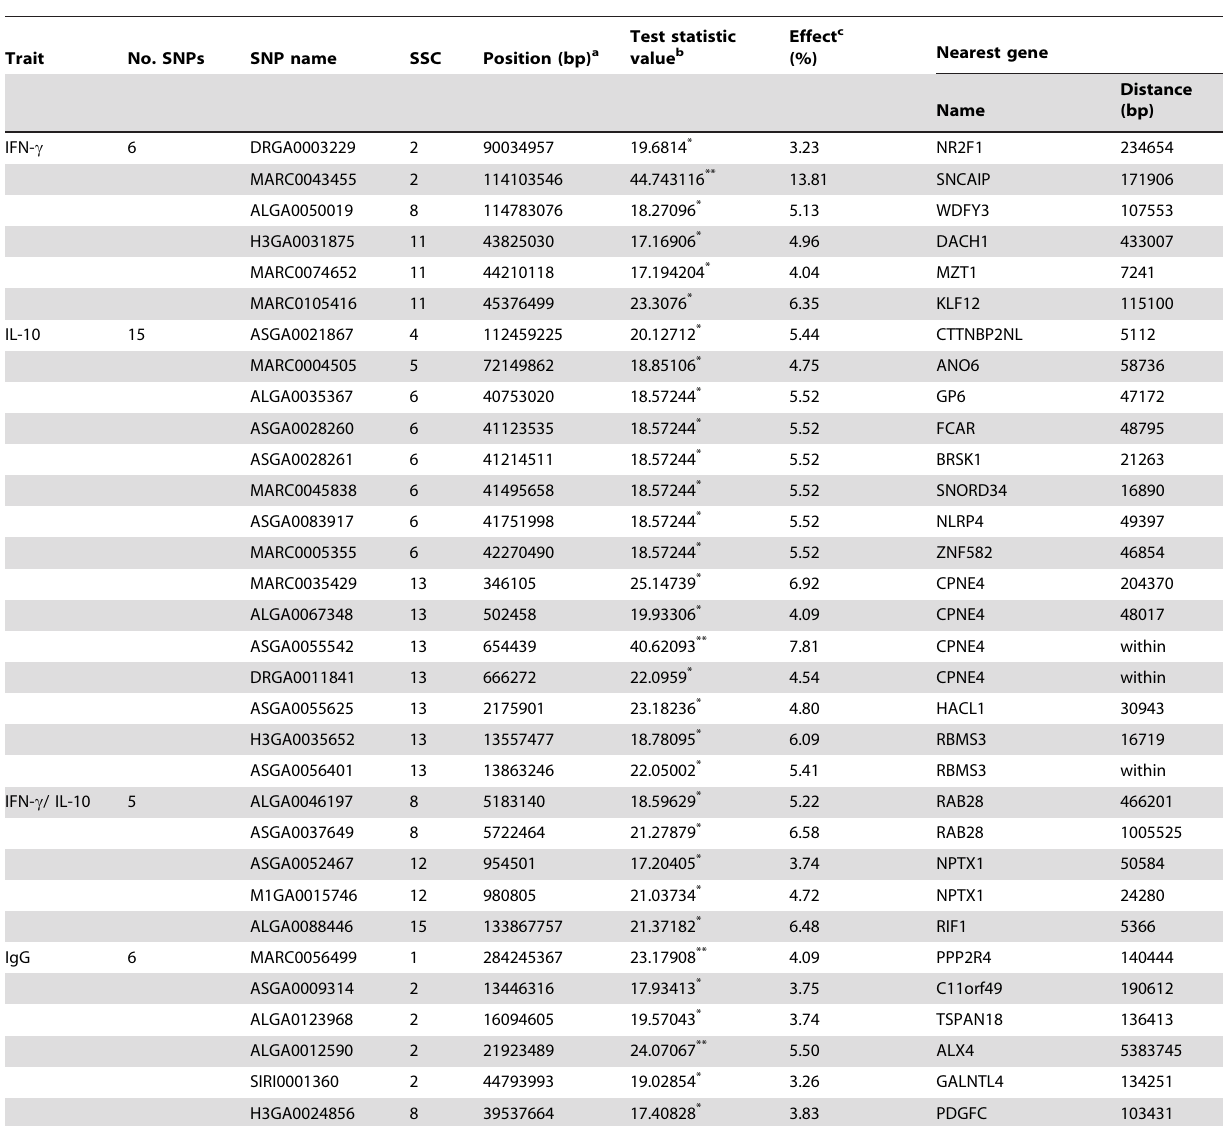
Table 4. Significant SNPs for the IgG and cytokine concentration in peripheral blood.